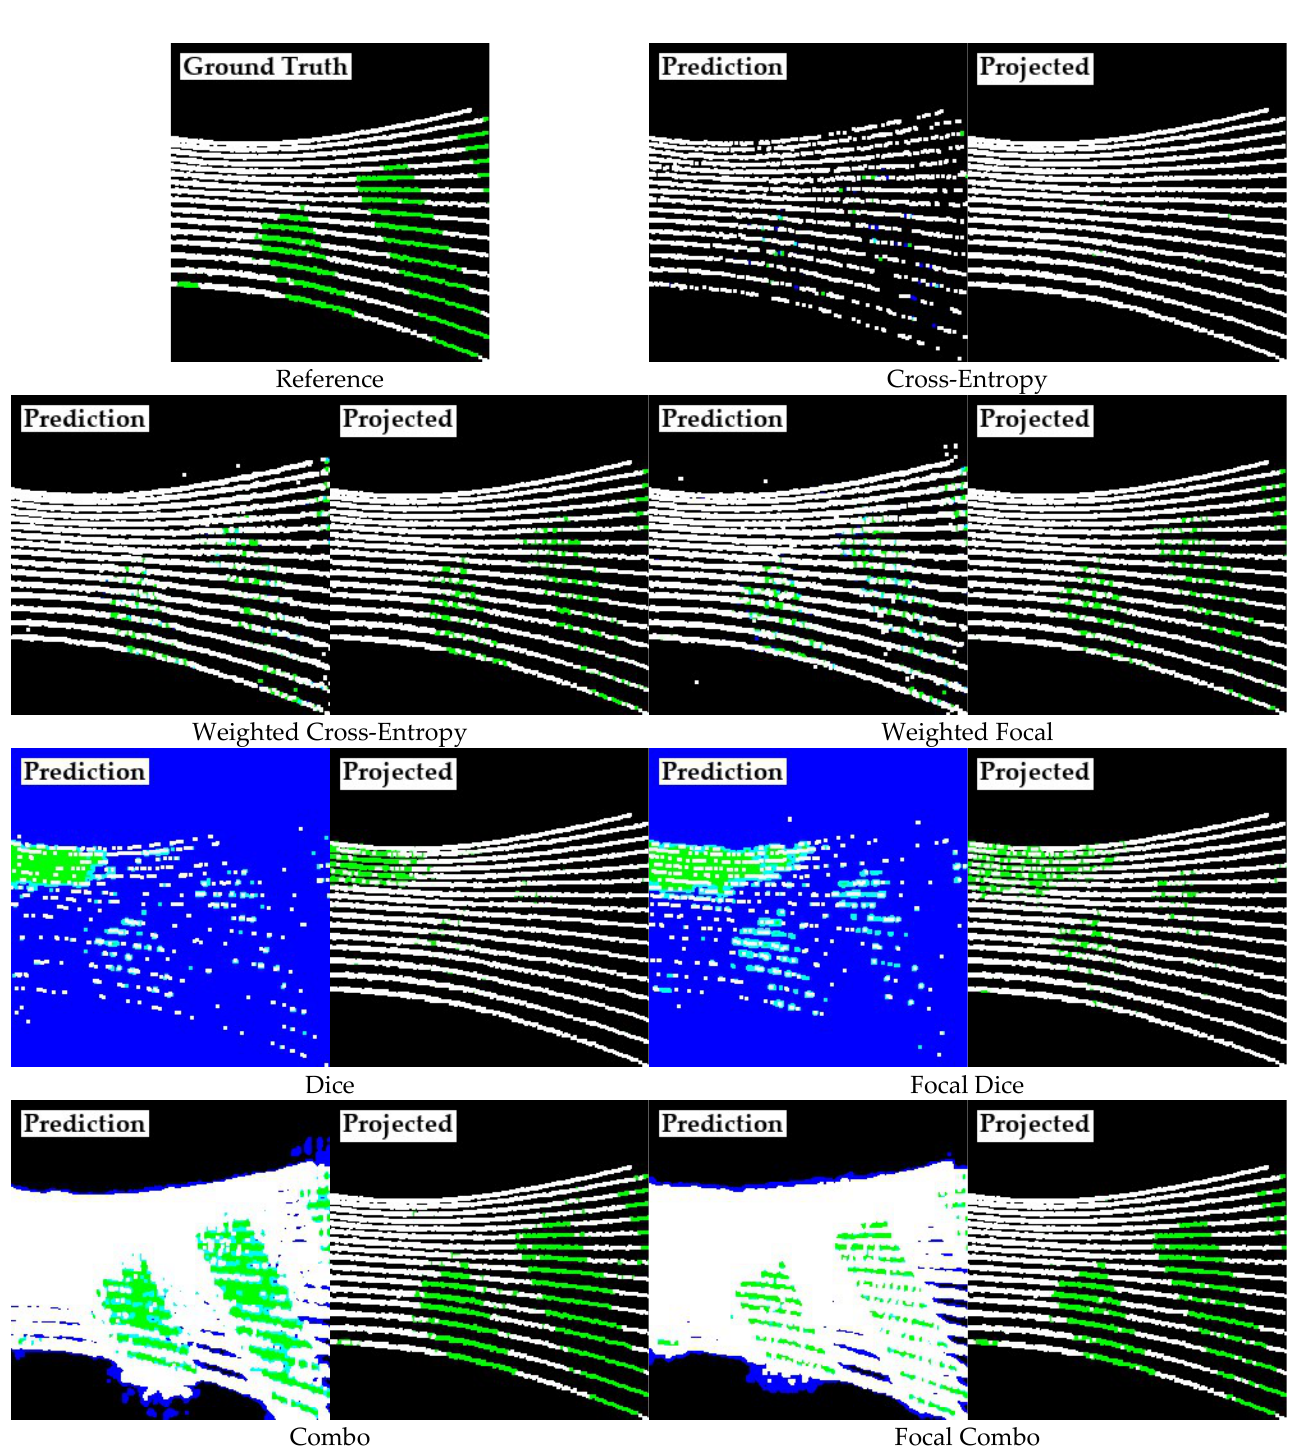
Figure 8. Sample prediction results and projected counterparts using U-Net.